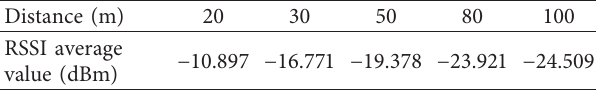
Table 1: RSSI average value and distance data.